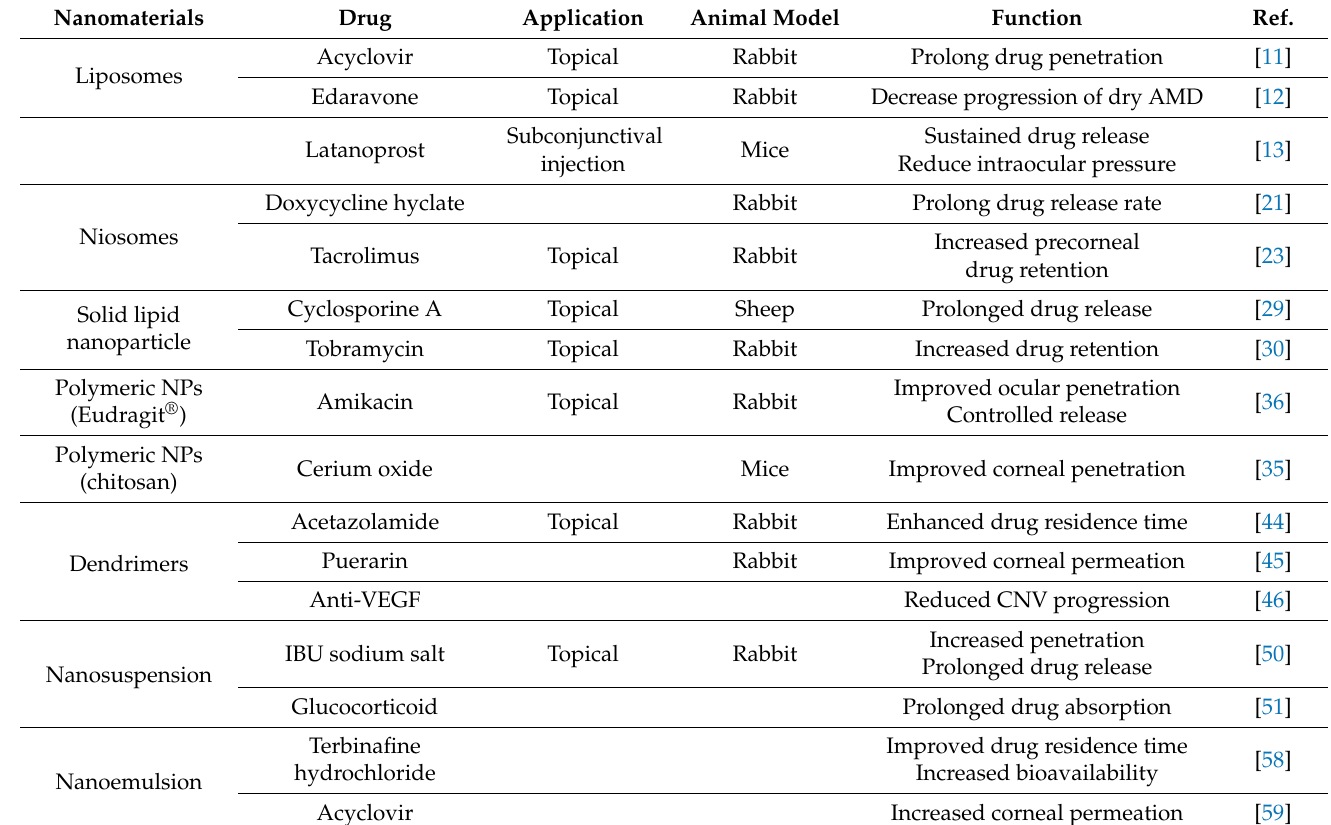
Table 1. Summarizes the applications of organic nanoparticles for drug delivery to ocular surfaces. Table 1. Applications of organic nanoparticles for ophthalmic drug